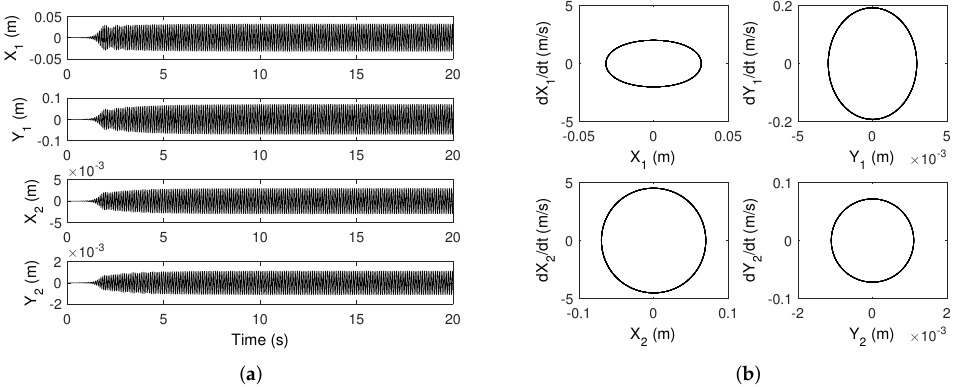
Figure 3. Nonlinear transient and steady-state self-excited friction-induced vibrations for µ = 0.4. ( a ) Displacements. ( b ) Limit cycles.